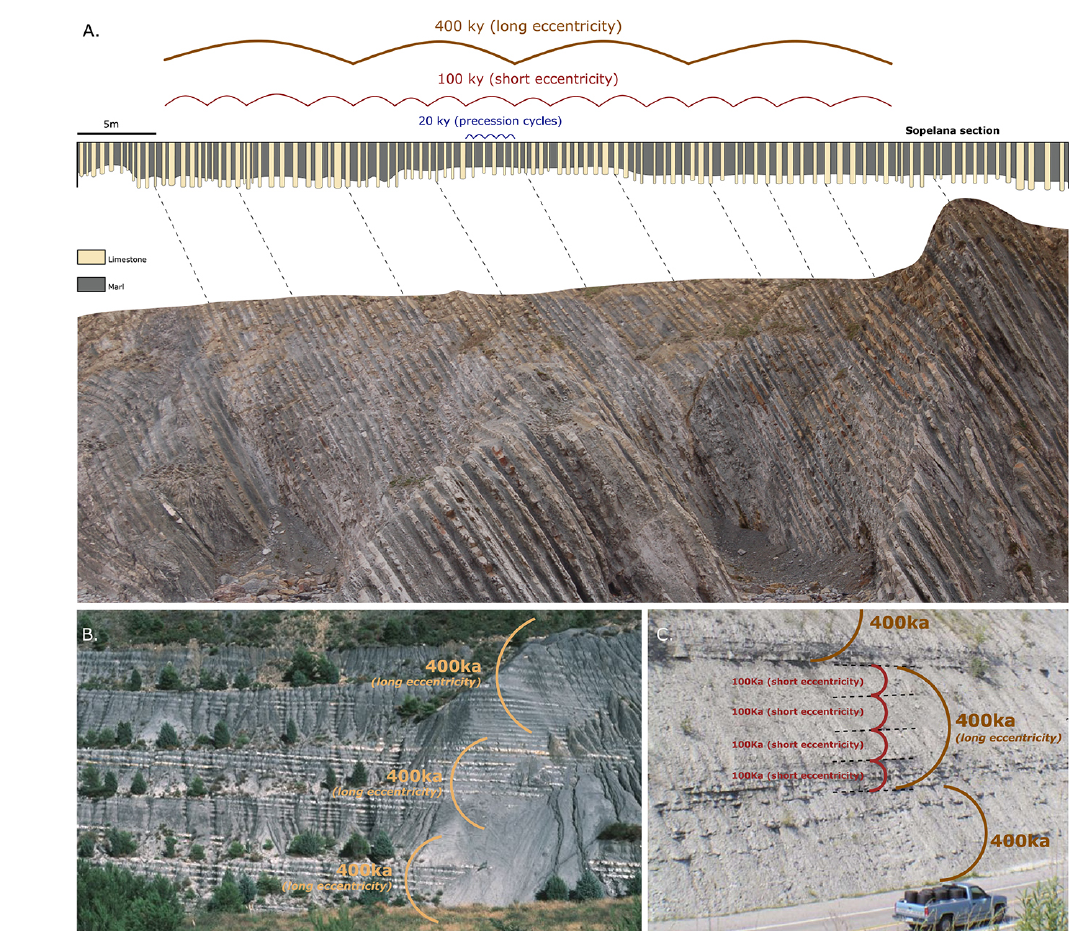
Figure 29. Outcrop examples of sedimentary cycles determined by cyclostratigraphic analysis. (a) Long eccentricity, short eccentricity, and precession cycles in hemipelagic limestone and marl alternations of the Sopelana section (Maastrichtian), Spain (modified from Batenburg et al., 2014); (b) long eccentricity cycles in hemipelagic limestone and marl alternations of the La Marcouline section (Middle Aptian), France (modified from Kuhnt and Moullade, 2007); (c) long and short eccentricity cycles in shallow-marine deposits of the Kope Formation (Ordovician), United States (modified from Ellwood et al.,